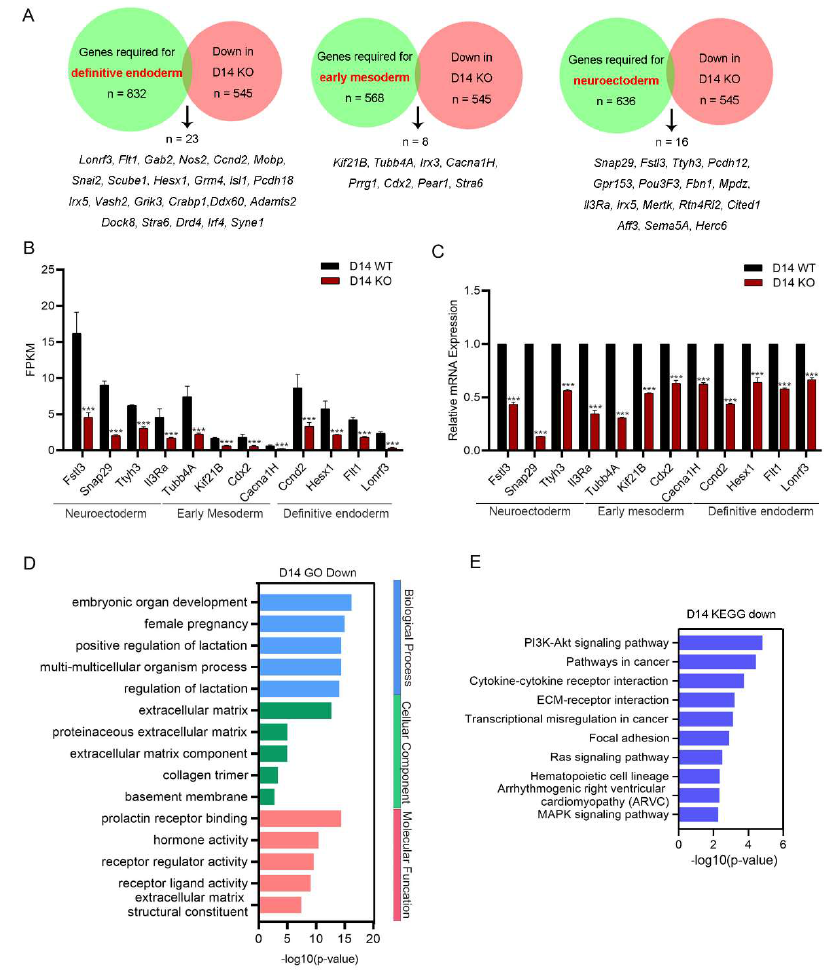
Figure 5. Downregulated genes in Snap29 −/− differentiated cells are involved in the proper differentiation of ESCs. ( A ) Venn diagrams of downregulated genes in Snap29 −/− differentiated cells overlapping with genes required for definitive endoderm, early mesoderm, and neuroectoderm formation [19]. ( B ) FPKMs of representative genes involved in the development of the definitive endoderm, early mesoderm, and neuroectoderm. ( C ) Expression analysis of genes in ( B ) through qPCR. ( D ) GO analysis of downregulated genes in Snap29 −/− differentiated cells. ( E ) The enriched KEGG pathways analyzed through downregulated genes in Snap29 −/− differentiated cells. Mean ± SEM from three biological replicates. *** p < 0.001, unpaired two-tailed Student’s t -test.